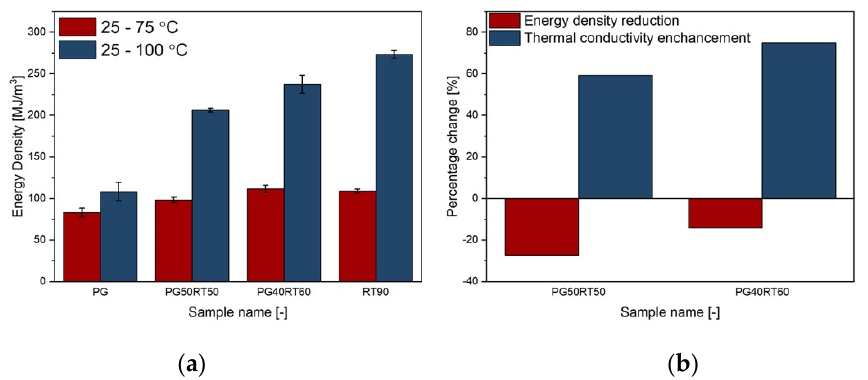
Figure 3. ( a ) Energy storage density at 25–75 °C and 25–100 °C; ( b ) Energy density reduction compared with thermal conductivity enhancement.